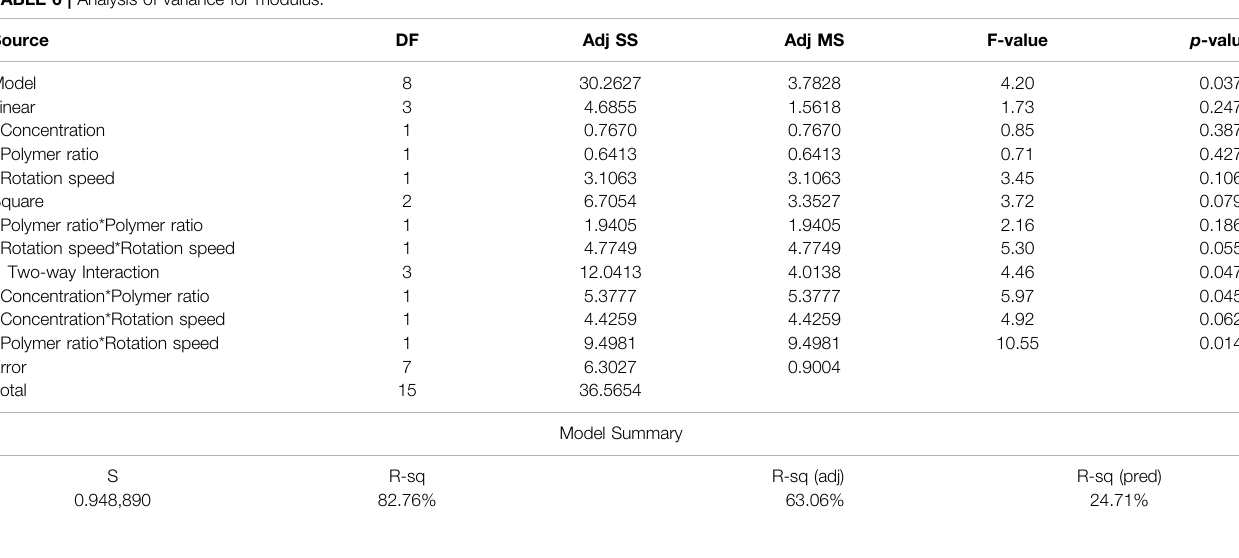
TABLE 6 | Analysis of variance for